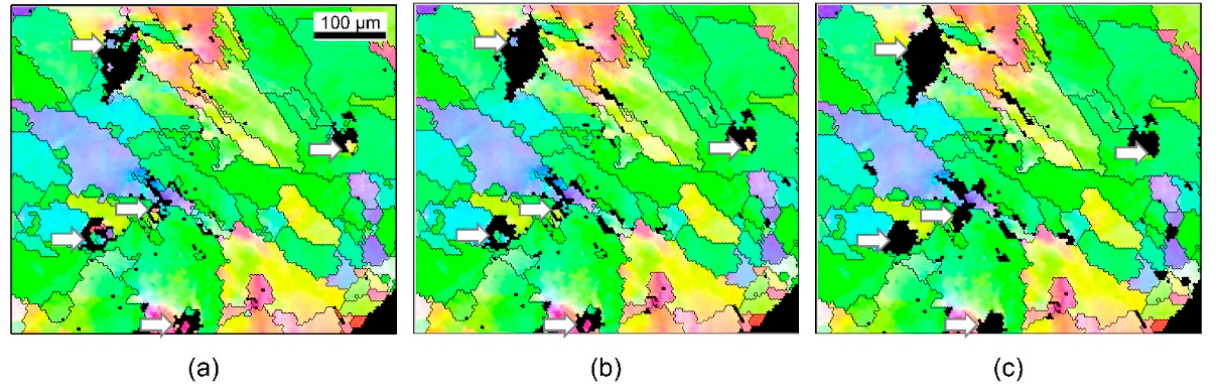
Figure 8. Variations of erroneous grains in voids according to the setup of minimum grain size: number of pixels ( a ) 2, ( b ) 5, and ( c ) 10.